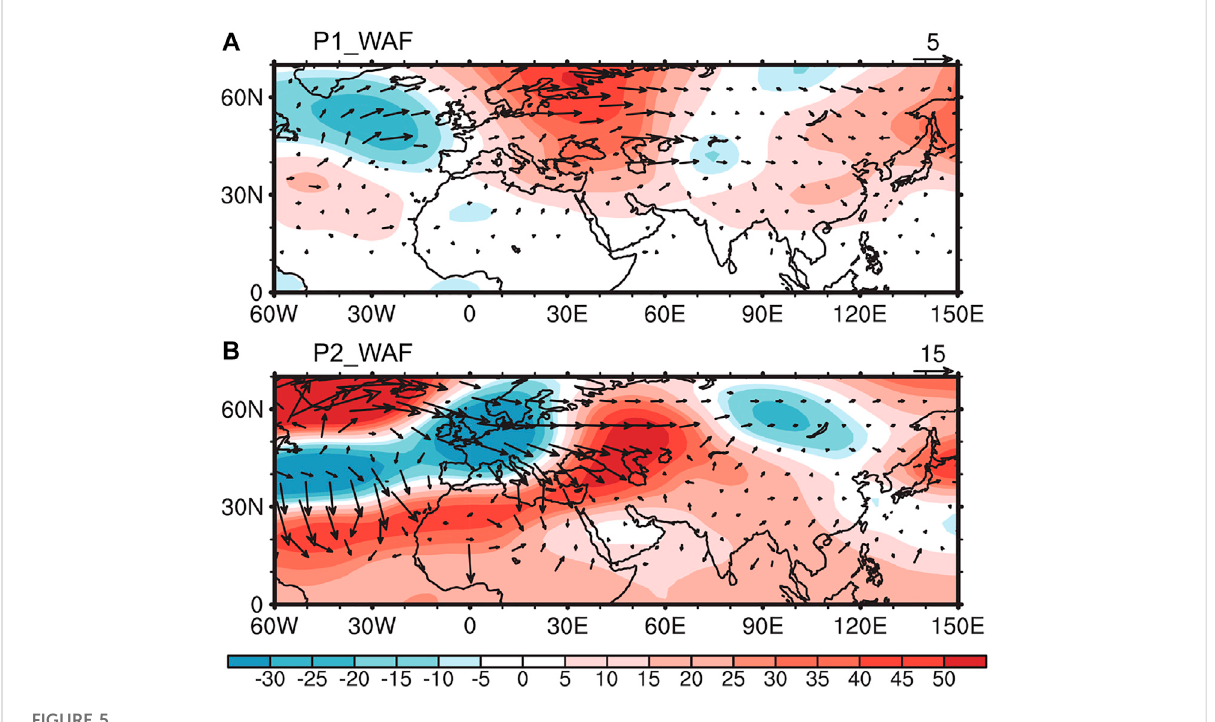
FIGURE 5 The 200 hPa geopotential height (unit: gpm) and wave activity fl ux (vector, unit: m 2 s − 2 ) anomalies for warm North Atlantic years during (A) P1 and (B)